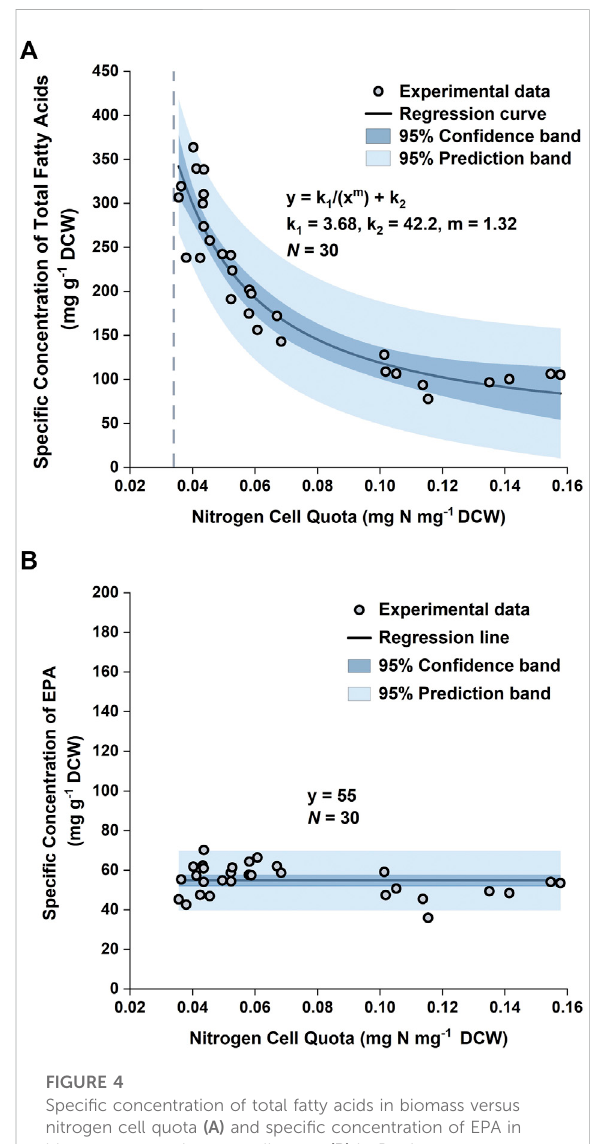
FIGURE 4 Speci fi c concentration of total fatty acids in biomass versus nitrogen cell quota (A) and speci fi c concentration of EPA in biomass versus nitrogen cell quota (B) in P. tricornutum . Datapoints were pooled from three biologically independent